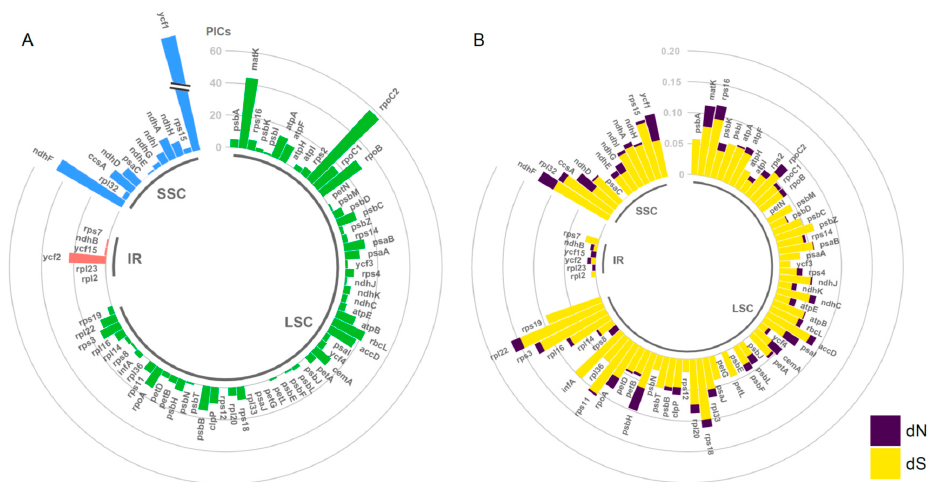
Figure 2. Sliding window analysis showing the nucleotide diversity ( Pi ), GC content, and gap proportion in the five Pogostemon chloroplast genome sequences, using 600 bp windows and a 200 bp step size.